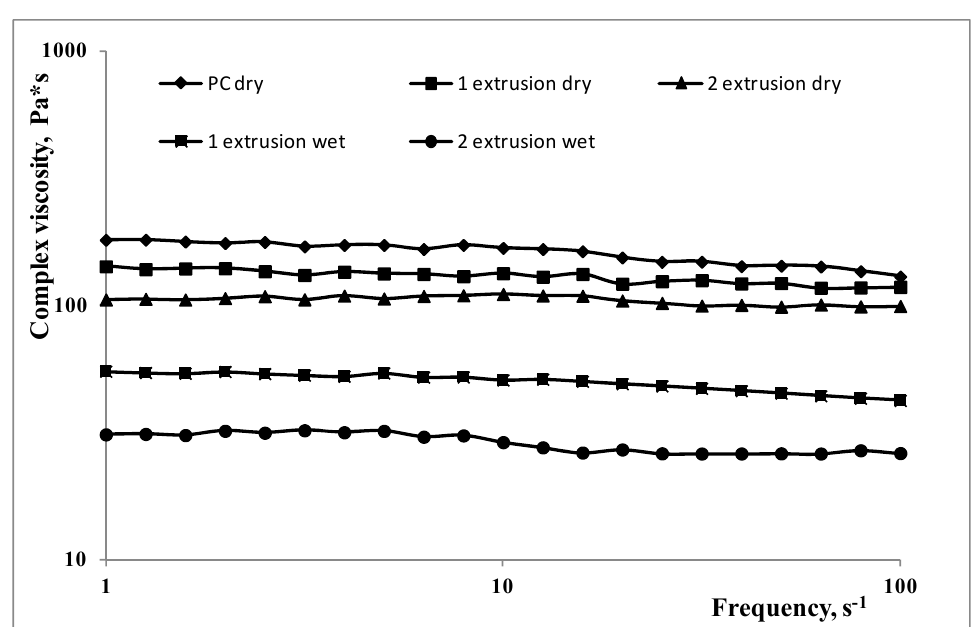
Figure 7. Flow curves of the post ‐ consumer polycarbonate after the extrusion steps for both dry and wet samples.